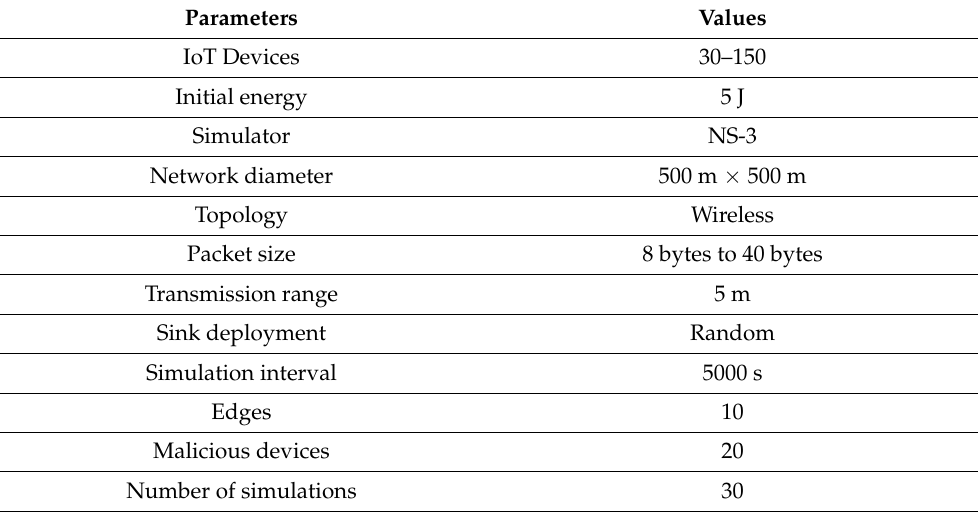
Table 3. Simulation